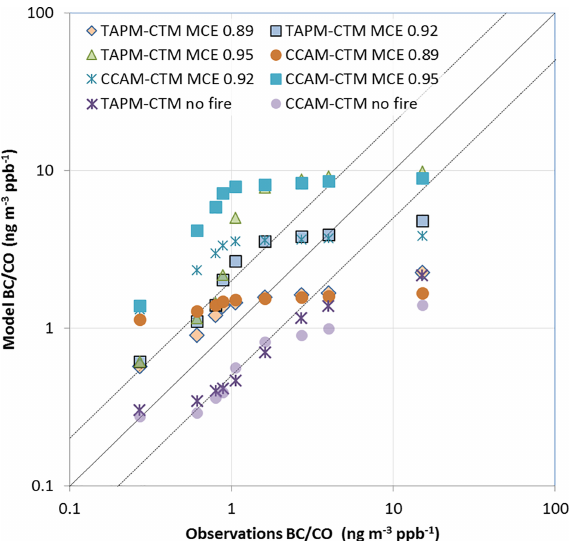
Figure 8. Quantile–quantile plots of observed and modelled BC / CO ratios for the TAPM–CTM and CCAM–CTM simulations. For each scenario, the model–data pairs correspond to the follow- ing percentiles: 0.2, 0.3, 0.4, 0.5, 0.6, 0.7, 0.8, 0.9 and 1. Note the log scale on both axes. The solid line is 1 : 1 and dotted lines show performance within a factor of 2.